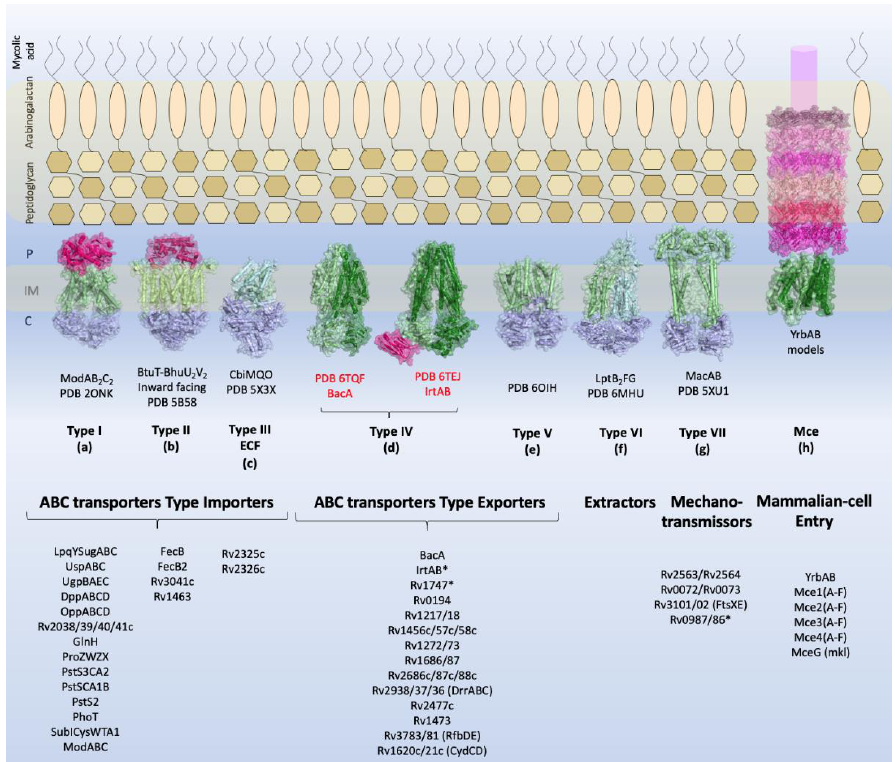
Figure 1. Overview of the types of ABC transporters and the components identified in M. tuberculosis . Schematic view of the M. tuberculosis cellular envelope is shown with the families of TMDABC